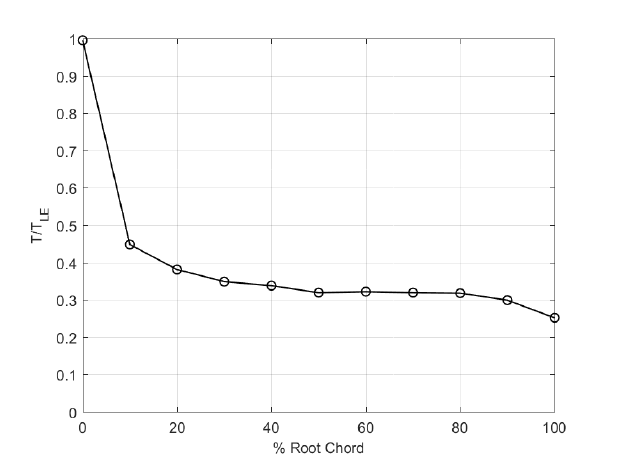
Figure 3. Applied temperature distribution on the wing model.